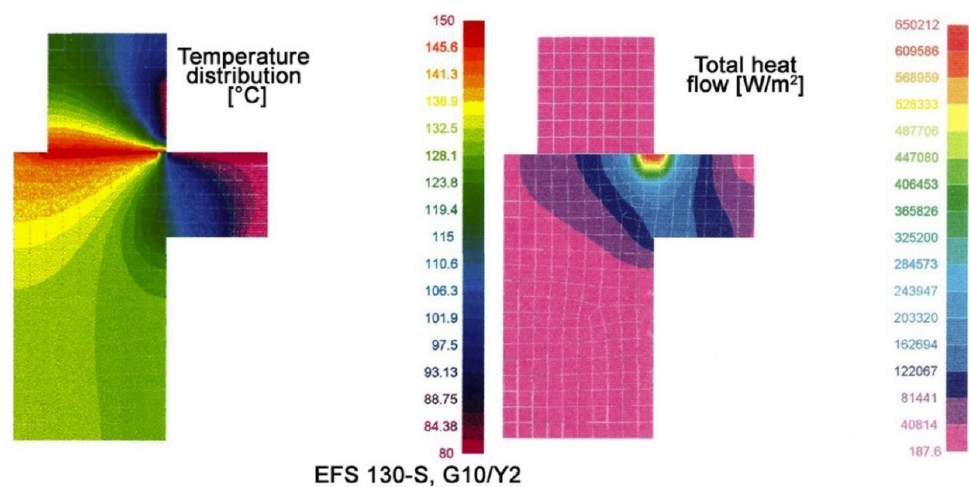
Figure 8. Temperature distribution and total heat flow for MFS, EFS 103−S, G10/Y2.